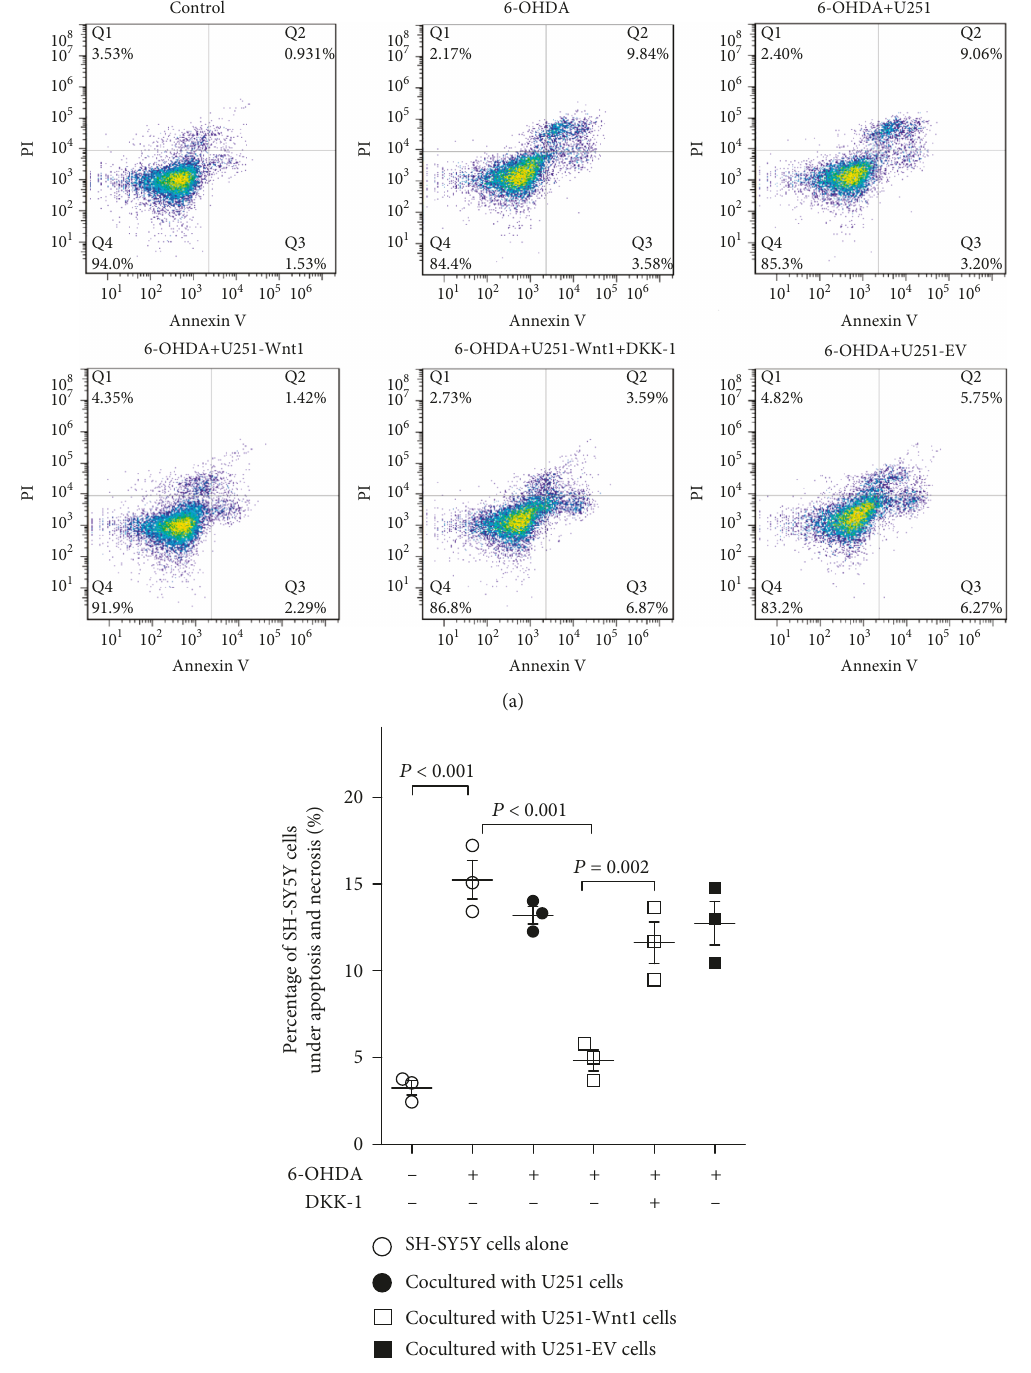
= 5 , betweengroups